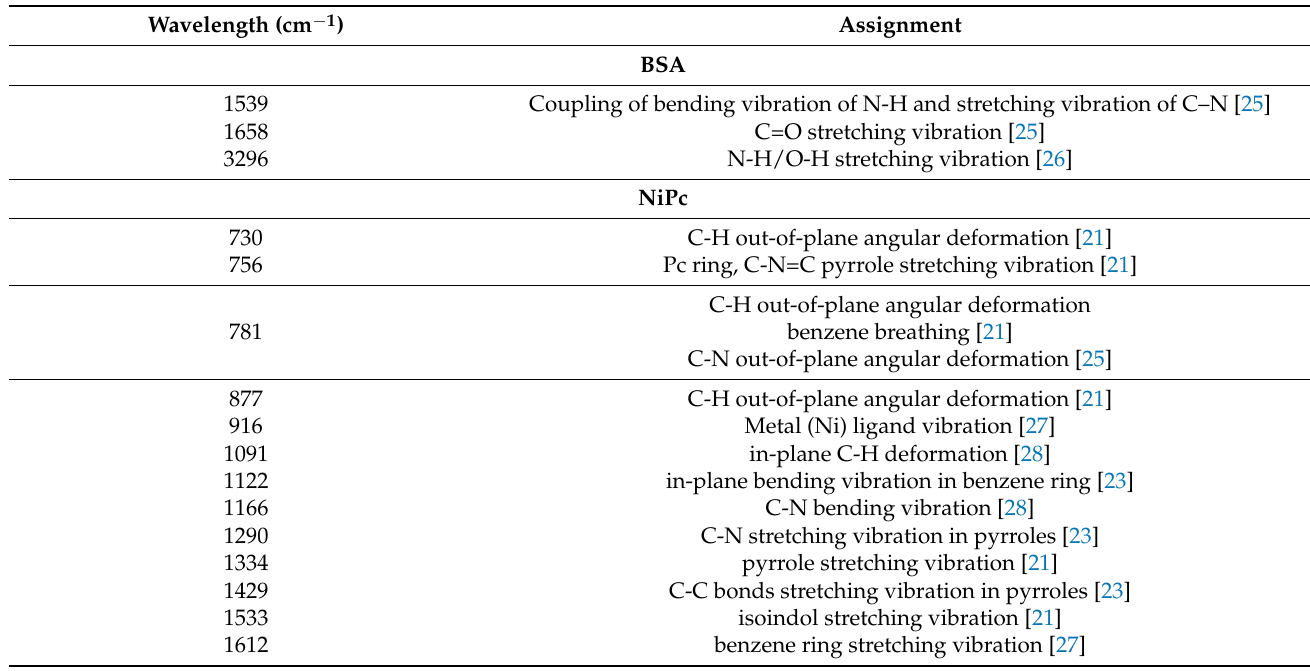
Table 1. Characterized peaks of FTIR of NiPc and BSA